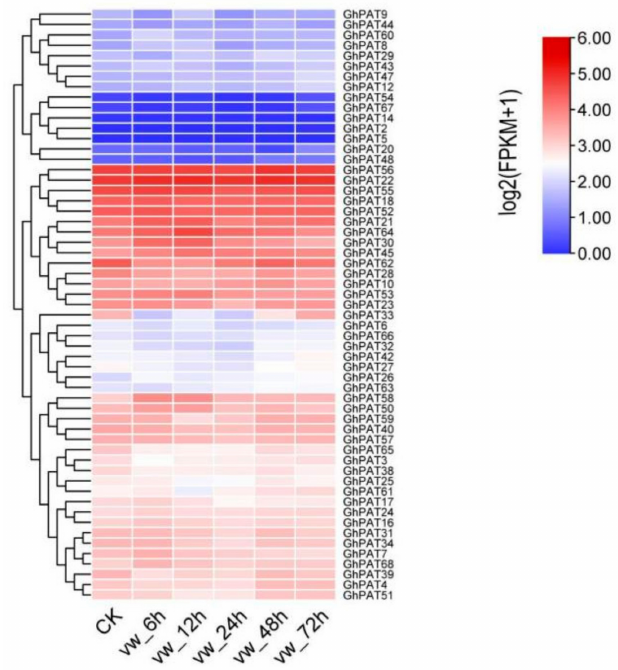
Figure 9. Expression analysis of GhPATs in V. dahliae